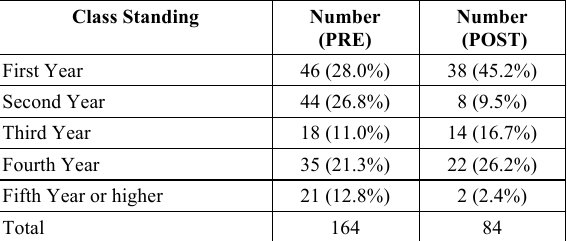
Table 4. Distribution of participants based on Class Standing